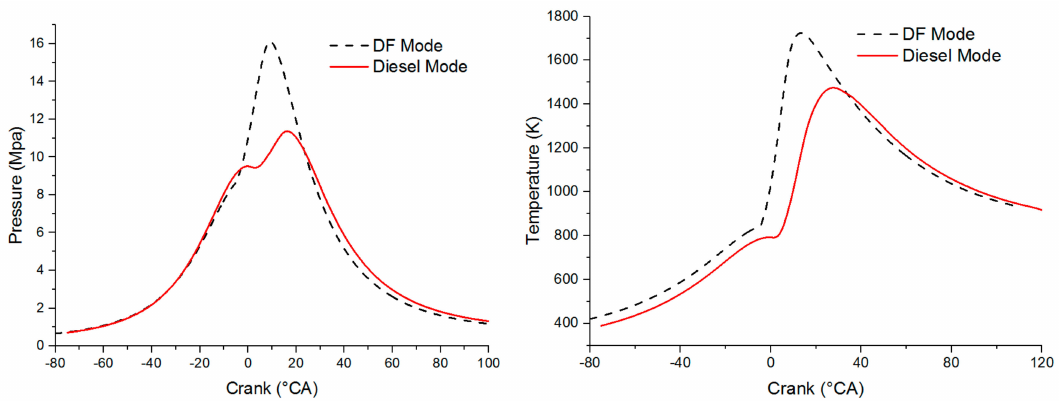
Figure 7. Comparison of pressure and temperature in di ff erent working